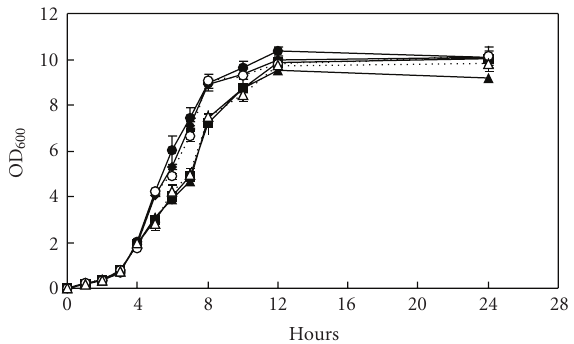
Figure 3: Kinetics of cell growth of both mutant and wild type of V. alginolyticus ZJ-51 , wild type (Op: closed circle; Tr: closed triangle), rpoX null mutant (Op: closed diamond; Tr: closed square), and complemented strains (Op: open circle; Tr: open triangle). Bacteria were grown in TSB medium in Erlenmeyer flasks, which were incubated at 30 ◦ C with 240rpm. Samples were taken at 1, 2, 3, 4, 5, 6, 7, 8, 10, 12, and 24 hours. For every sample, the OD at 600 nm was measured. Figure 4: Variation rate from the opaque to translucent colony phase was examined in ZJ-O, Δ rpoX -O, and C rpoX -O of V. alginolyticus ZJ-51. After static incubation in LB for 24 hours, percentages of switched colonies were 26.00%, 27.12%, and 26.78% in the wild, mutant, and complemented strains,